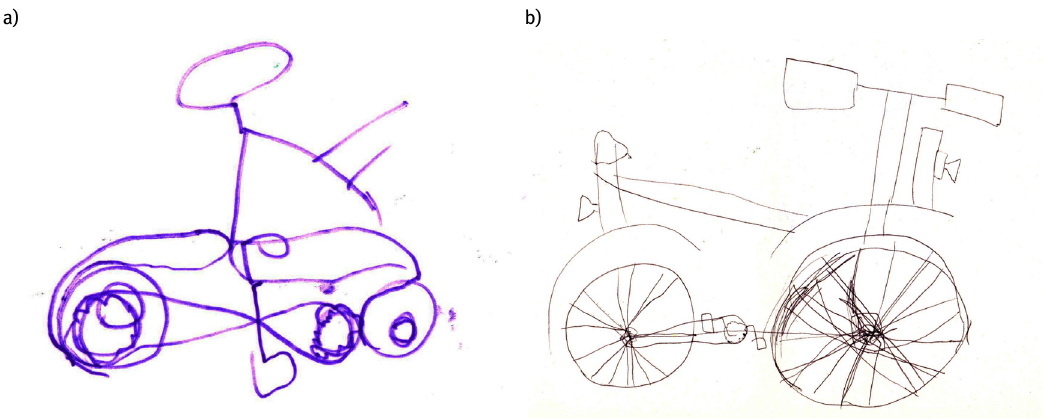
Figure 7. Drawing of a bike by a child with Asperger’s Syndrome A) at 2 years and B) at aged 4-5 years. Though this child does not have precocious drawing ability both depictions show an high level understanding of three-dimensional forms and how they relate to each other based on local processing